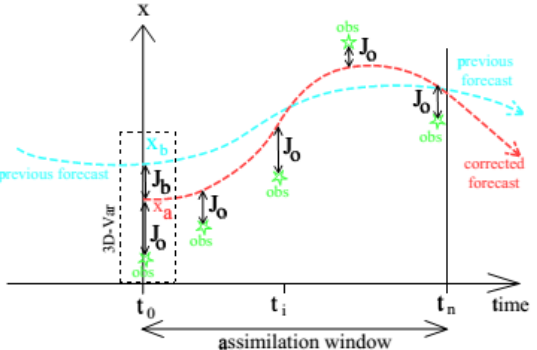
Figure 6. Example of 4D-VAR assimilation in a numerical forecasting system. Every 6 hours a 4DVAR is performed